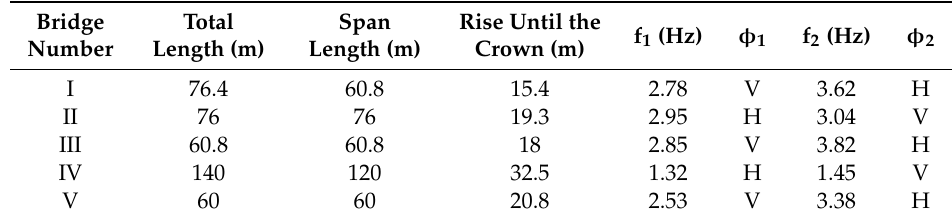
Table 1. Fundamental modal properties of a set of highway RC bridges in Southern Italy ( φ i means the i-th mode shape, V is for vertical bending, H is for horizontal bending).